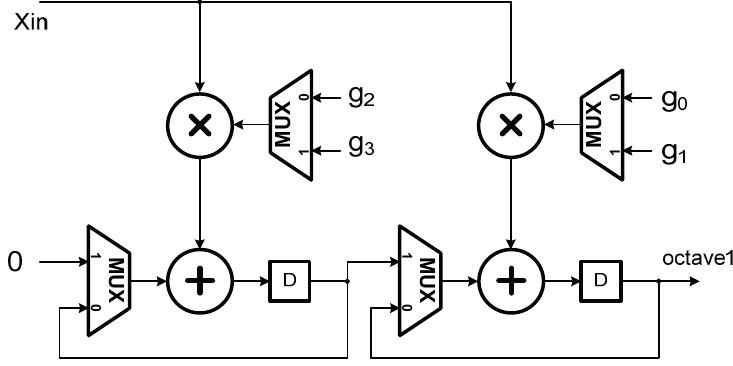
Figure 3. The first stage architecture of the 1D DWT as developed in [21].